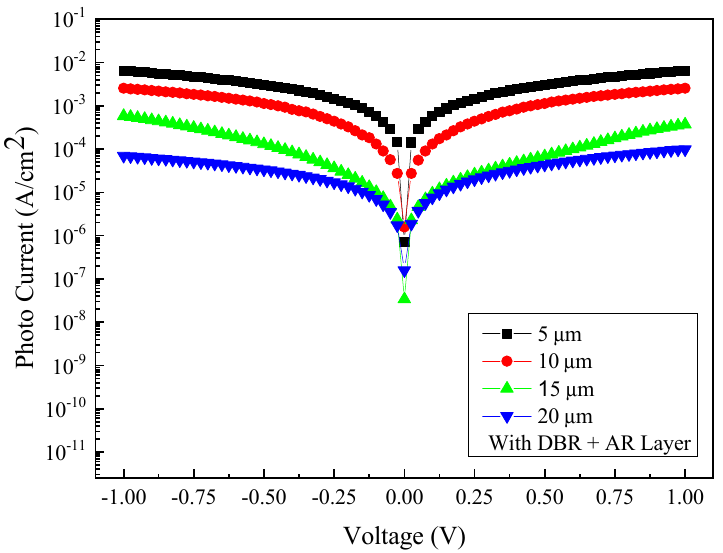
Figure 14. The photocurrent current of the AR/DBR-coated PDs with electrodes of four different sizes: 5 µm, 10 µm, 15 µm, and 20 µm.